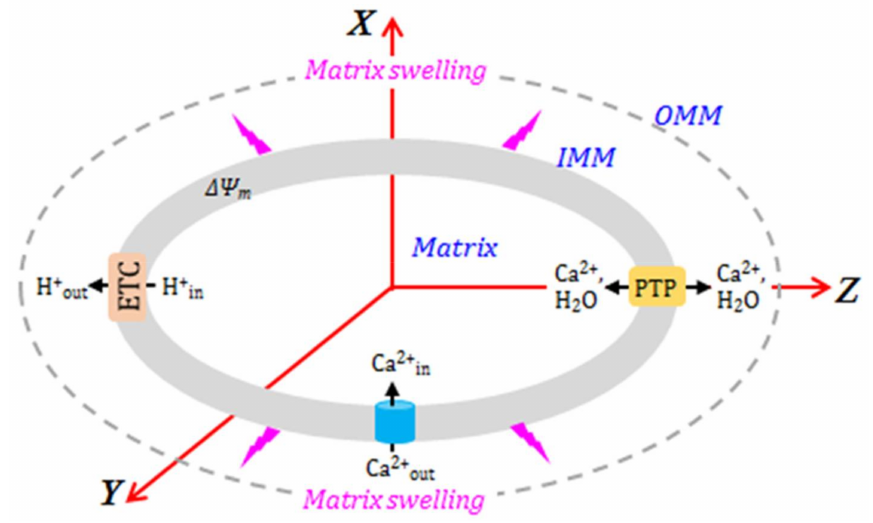
Figure 2. Biophysical approach to modeling mitochondrial